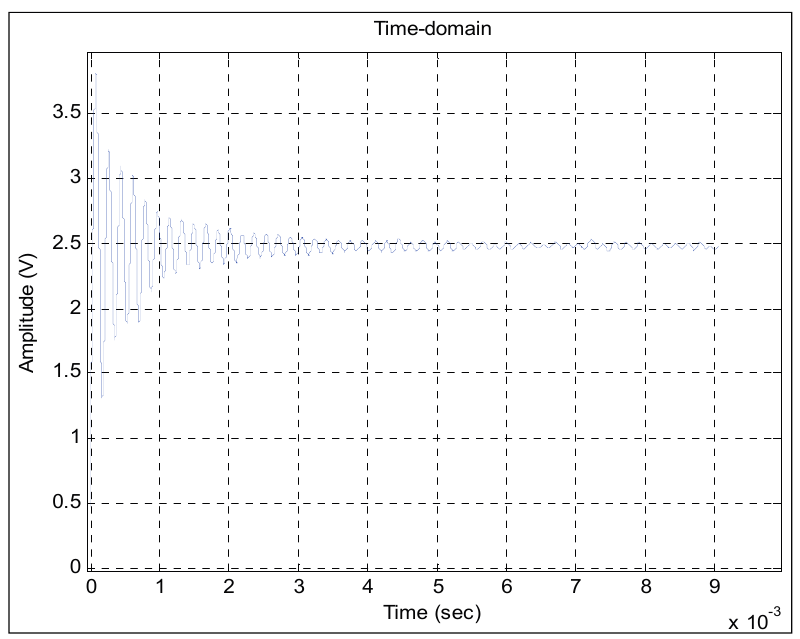
Figure 7. Filtering result obtained by the presented method in this